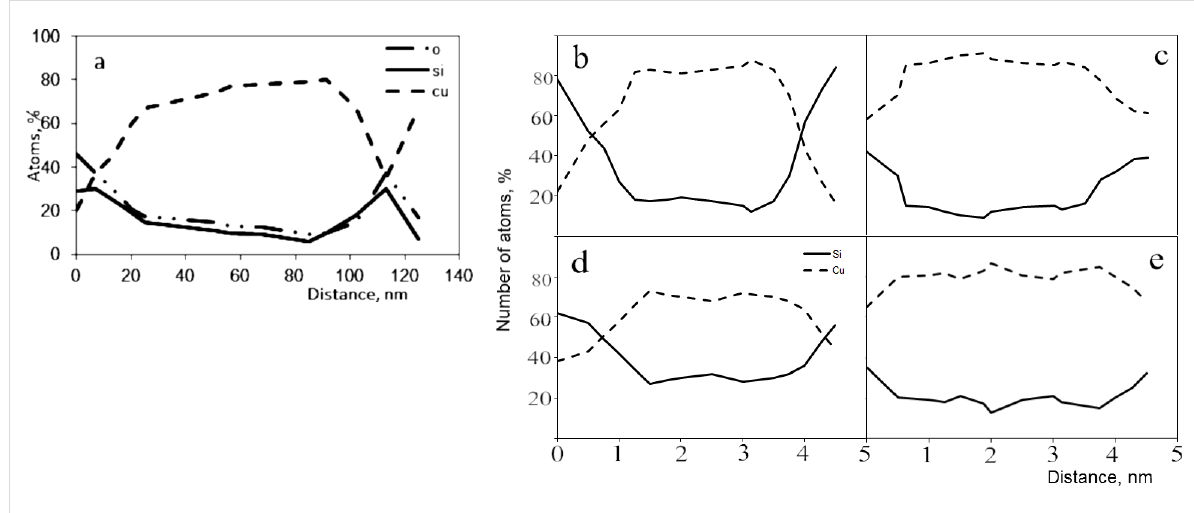
Figure 8: The distribution of the elements copper, silicon, and oxygen along a line passing through the centre of the nanoparticle; a) experimental result; b–e) modelling results with cooling rates of b) 1 K/ps, 50 atom % silicon, c) cooling rate 1 K/ps, 10 atom % silicon, d) cooling rate 1.5 K/ps, 50 atom % silicon), e) cooling rate 1.5 K/ps, 10 atom %